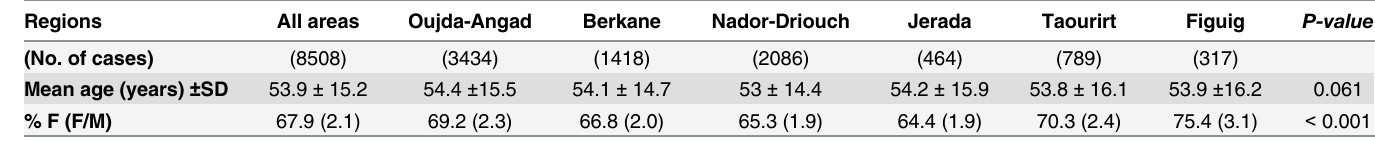
Table 1. Mean age at diagnosis and sex ratio for all cancers combined by area of Eastern Morocco, October 2005 – December 2012.